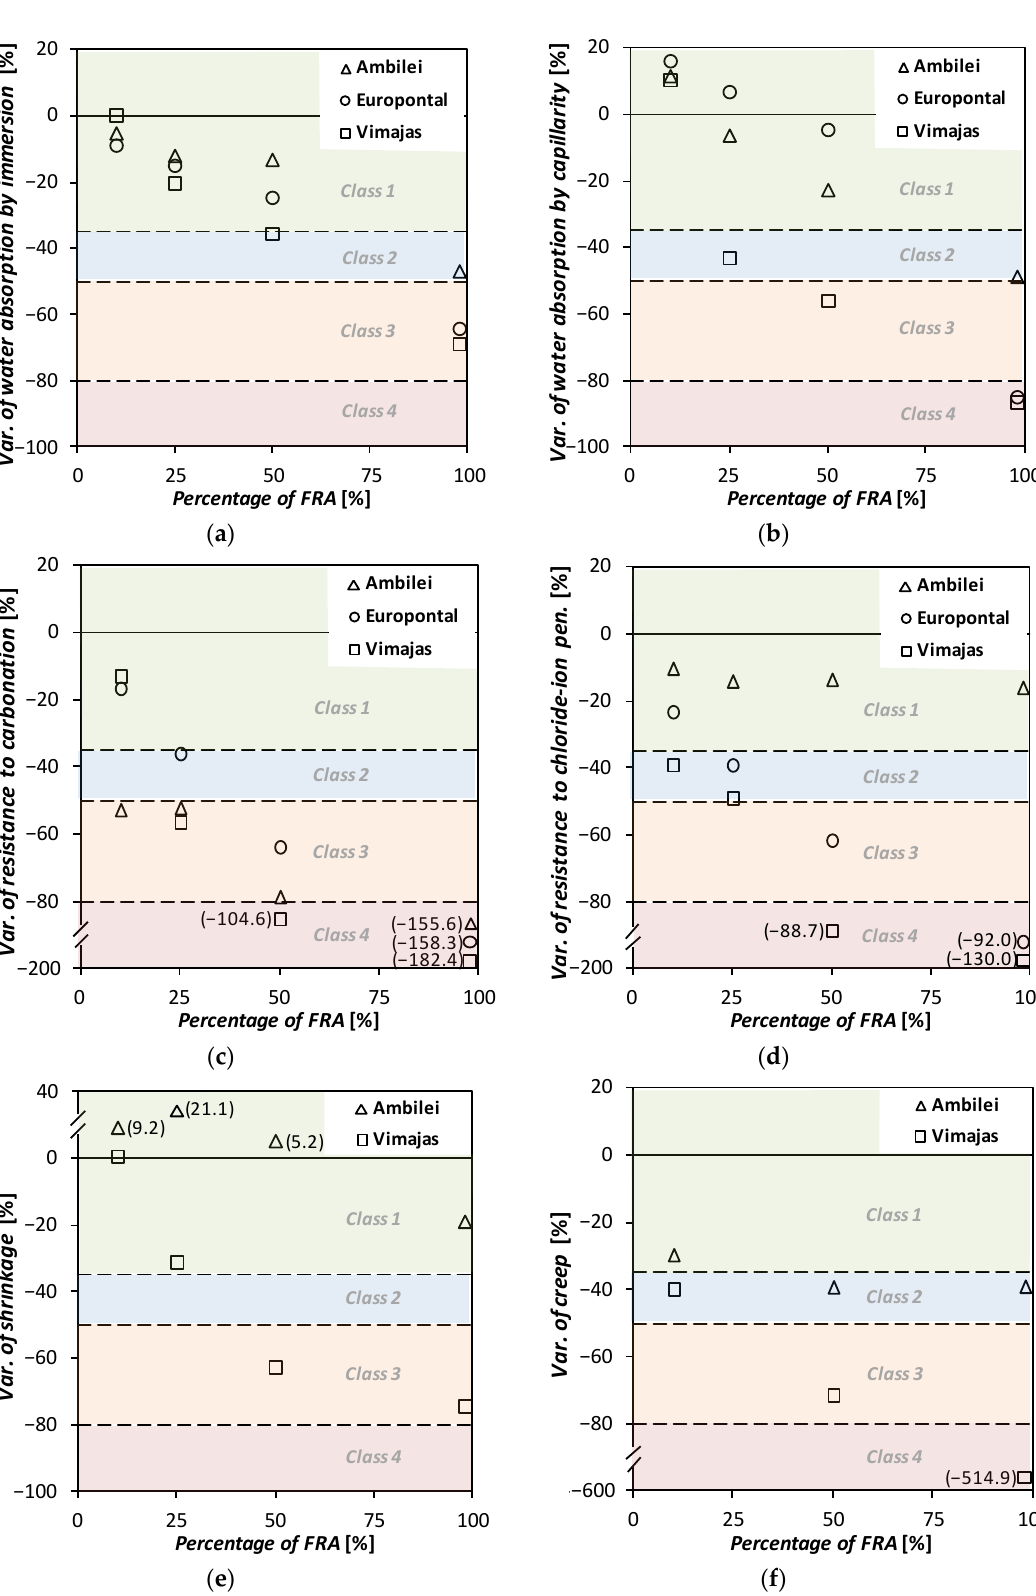
Figure 3. Variation of water absorption ( a ) by immersion and ( b ) by capillarity, of resistance to ( c ) carbonation and ( d ) chloride-ion penetration, ( e ) of shrinkage and ( f ) of creep of concrete made with FRA, relative to the reference concrete.